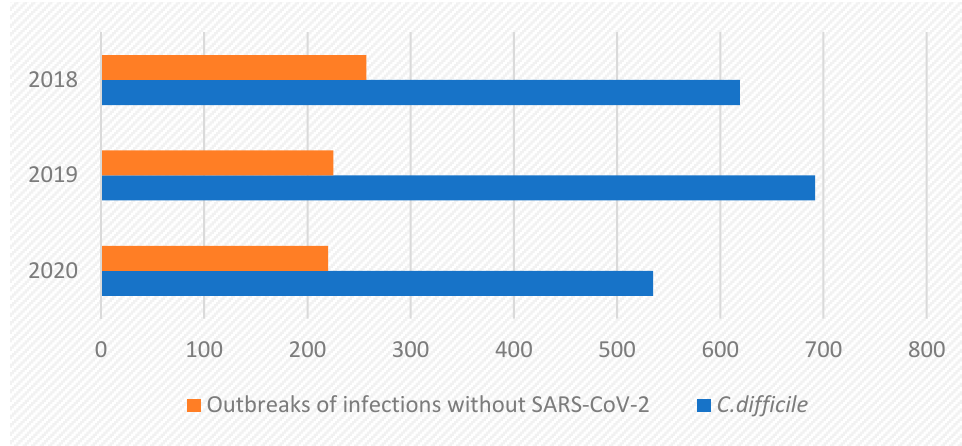
Figure 1. C. difficile outbreaks in Poland in 2018–2020 (Source: Chief Sanitary Inspector [11]).